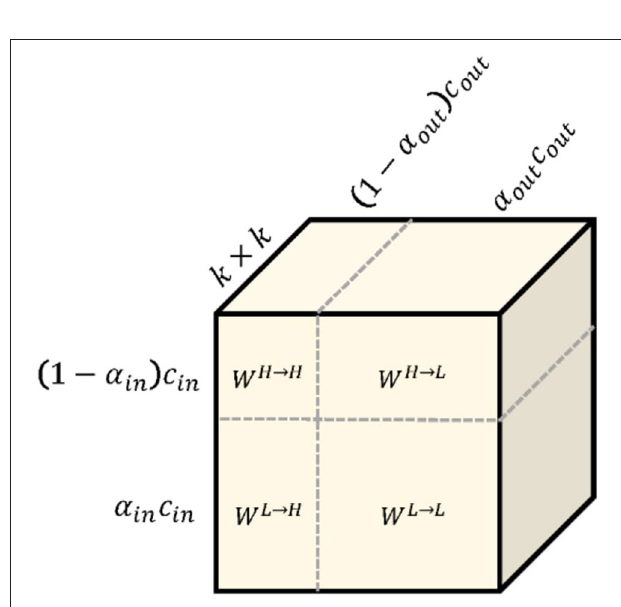
FIGURE 2 | The octave convolution kernel. k × k octave convolution kernel W is equivalent to vanilla convolution kernel because they have exactly the same number of